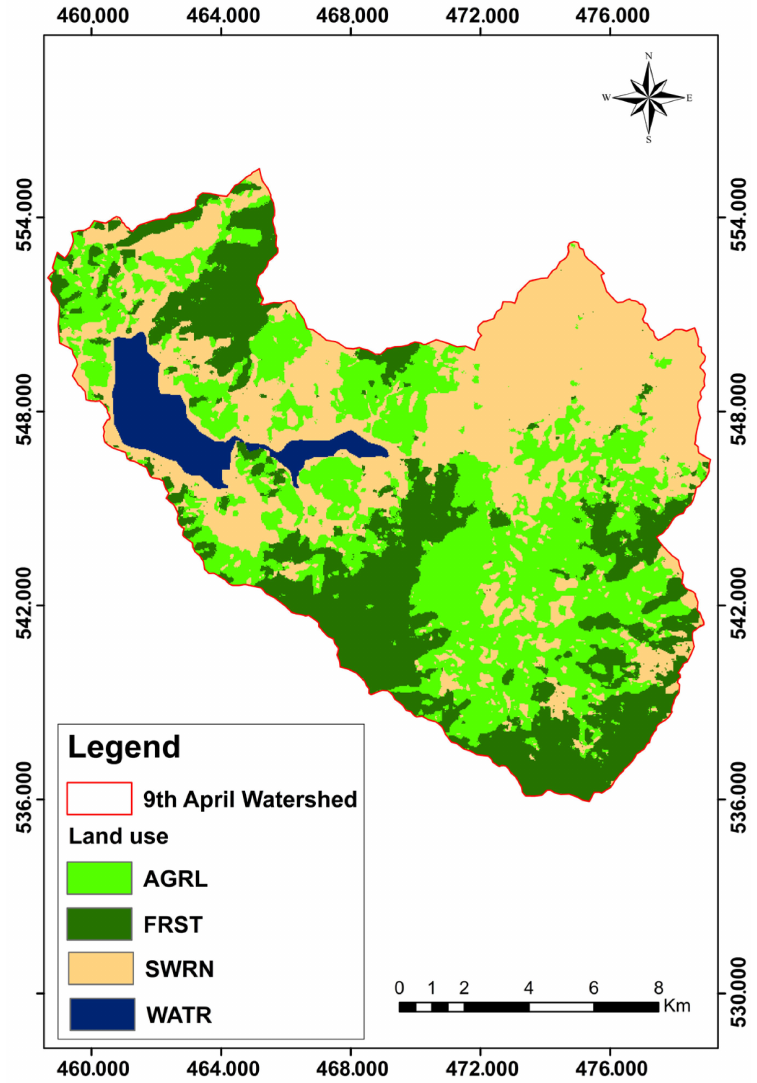
Figure 4. Simulated 2018 land